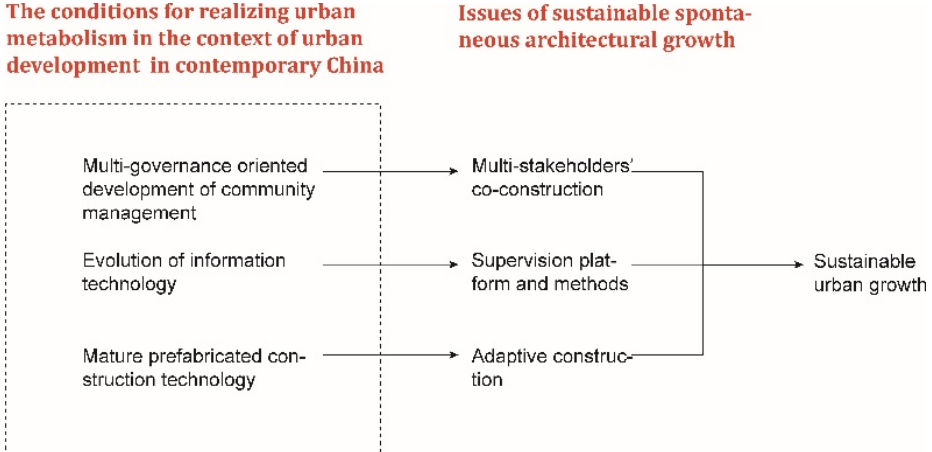
Figure 6. The one–to–one correspondence between the conditions for realizing urban metabolism in the context of urban development in contemporary China and the sustainable spontaneous elements for architectural growth (Source: author).